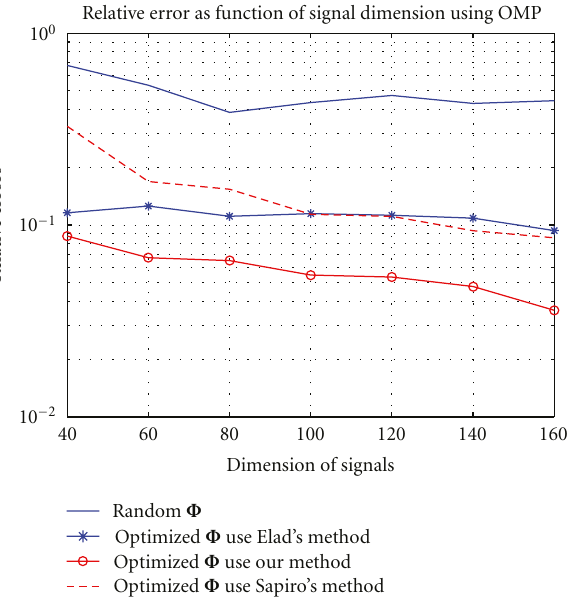
Figure 7: Relative errors as function of signal’s dimension n using